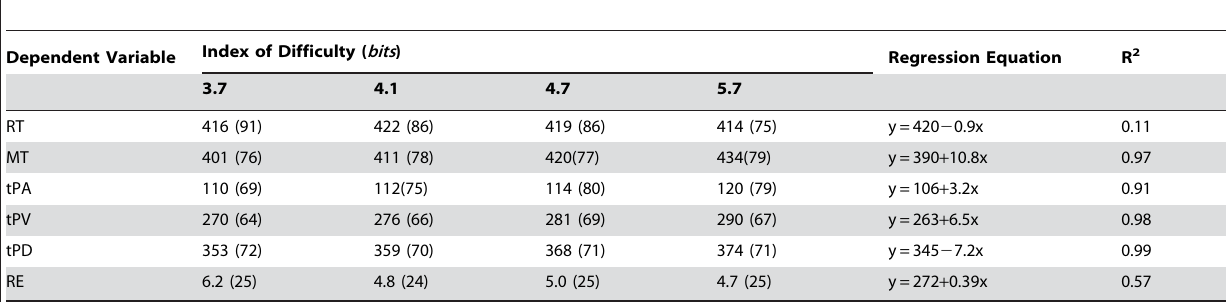
Table 1. Reaction time (RT: ms), movement time (MT: ms), time to peak acceleration (tPA: ms), time to peak velocity (tPV: ms), time to peak deceleration (tPD: ms) and resultant error (RE: mm) as a function of target index of